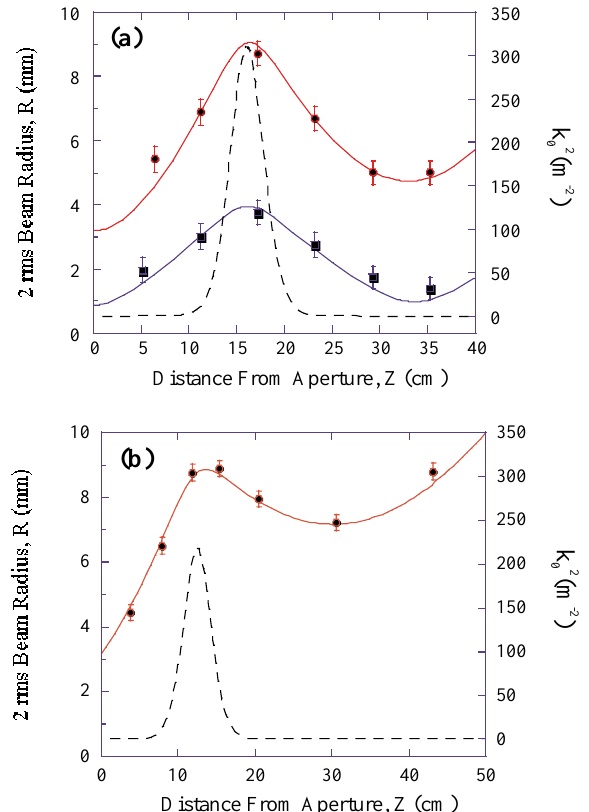
FIG. 4. (Color) KV envelope calculations and experimental (2 rms) radii for (a) full beam and smallest current beam (aperture 3 in Table I) from the gridded electron gun, and (b) full beam from the convergent-type gun. The focusing function k 2 0 (cid:2) z (cid:3) (dashed line) is proportional to the solenoid B field